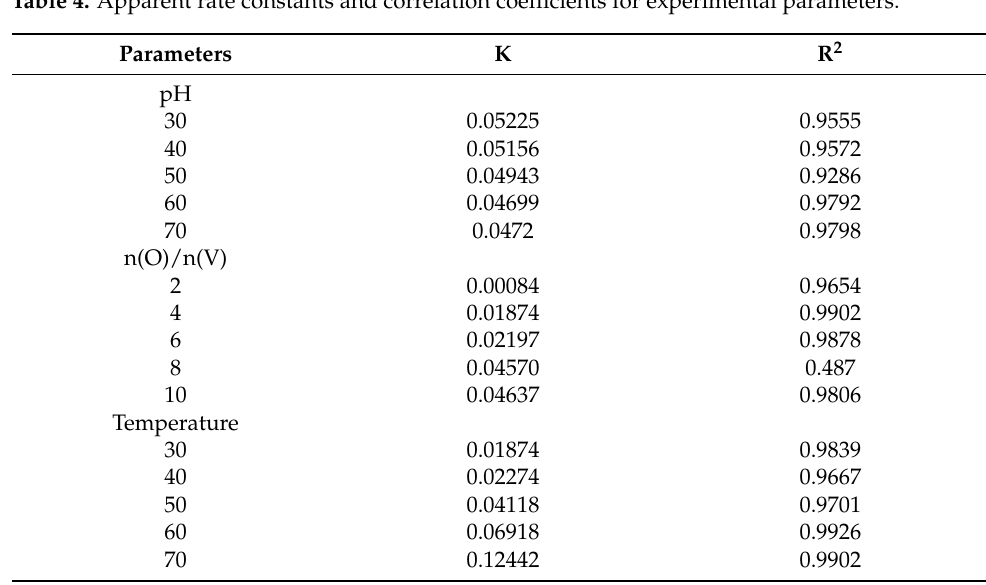
Figure 12. Kinetics plots: ( a ) Natural logarithm of reduction reaction constant vs. reciprocal temper- ature; ( b ) plot of K as a function of pH; ( c ) plot of K as a function of n(O)/n(V); ( d ) plot of K as a function of temperature. Table 4. Apparent rate constants and correlation coefficients for experimental